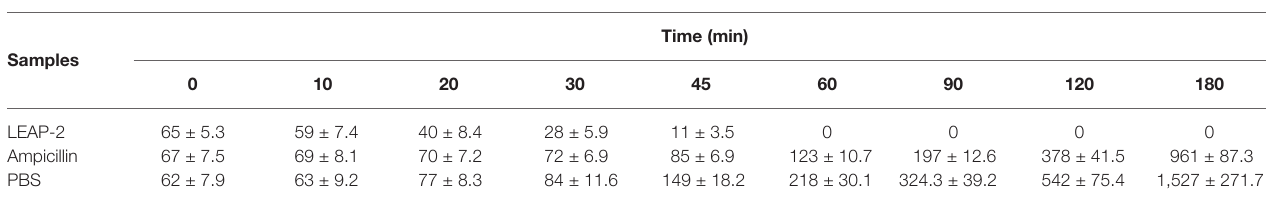
TABLE 3 | Killing kinetics of of topmouth culter LEAP-2 against Aeromonas hydrophila .